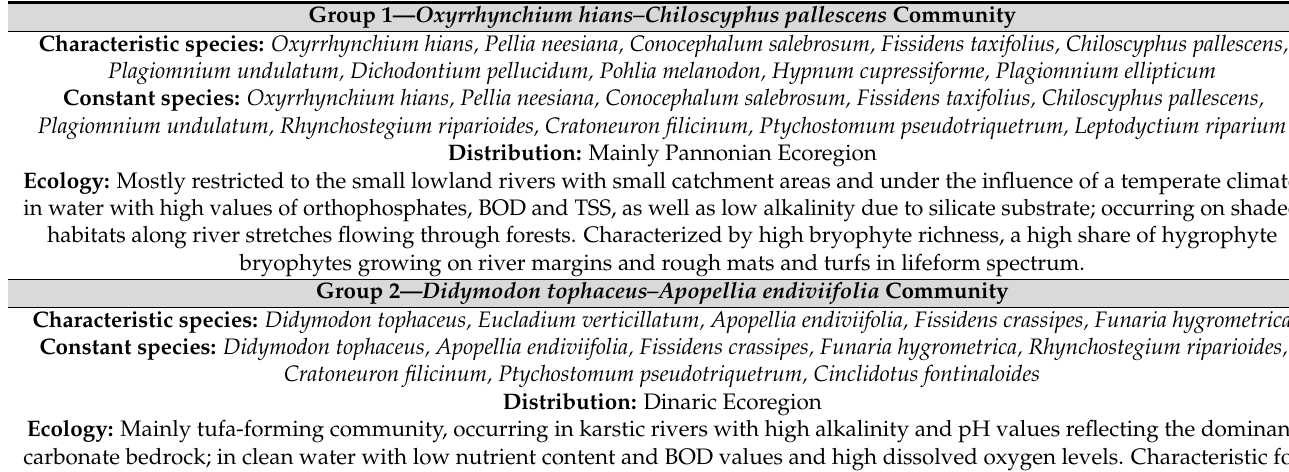
Table 4. Summary of TWINSPAN groups’ main